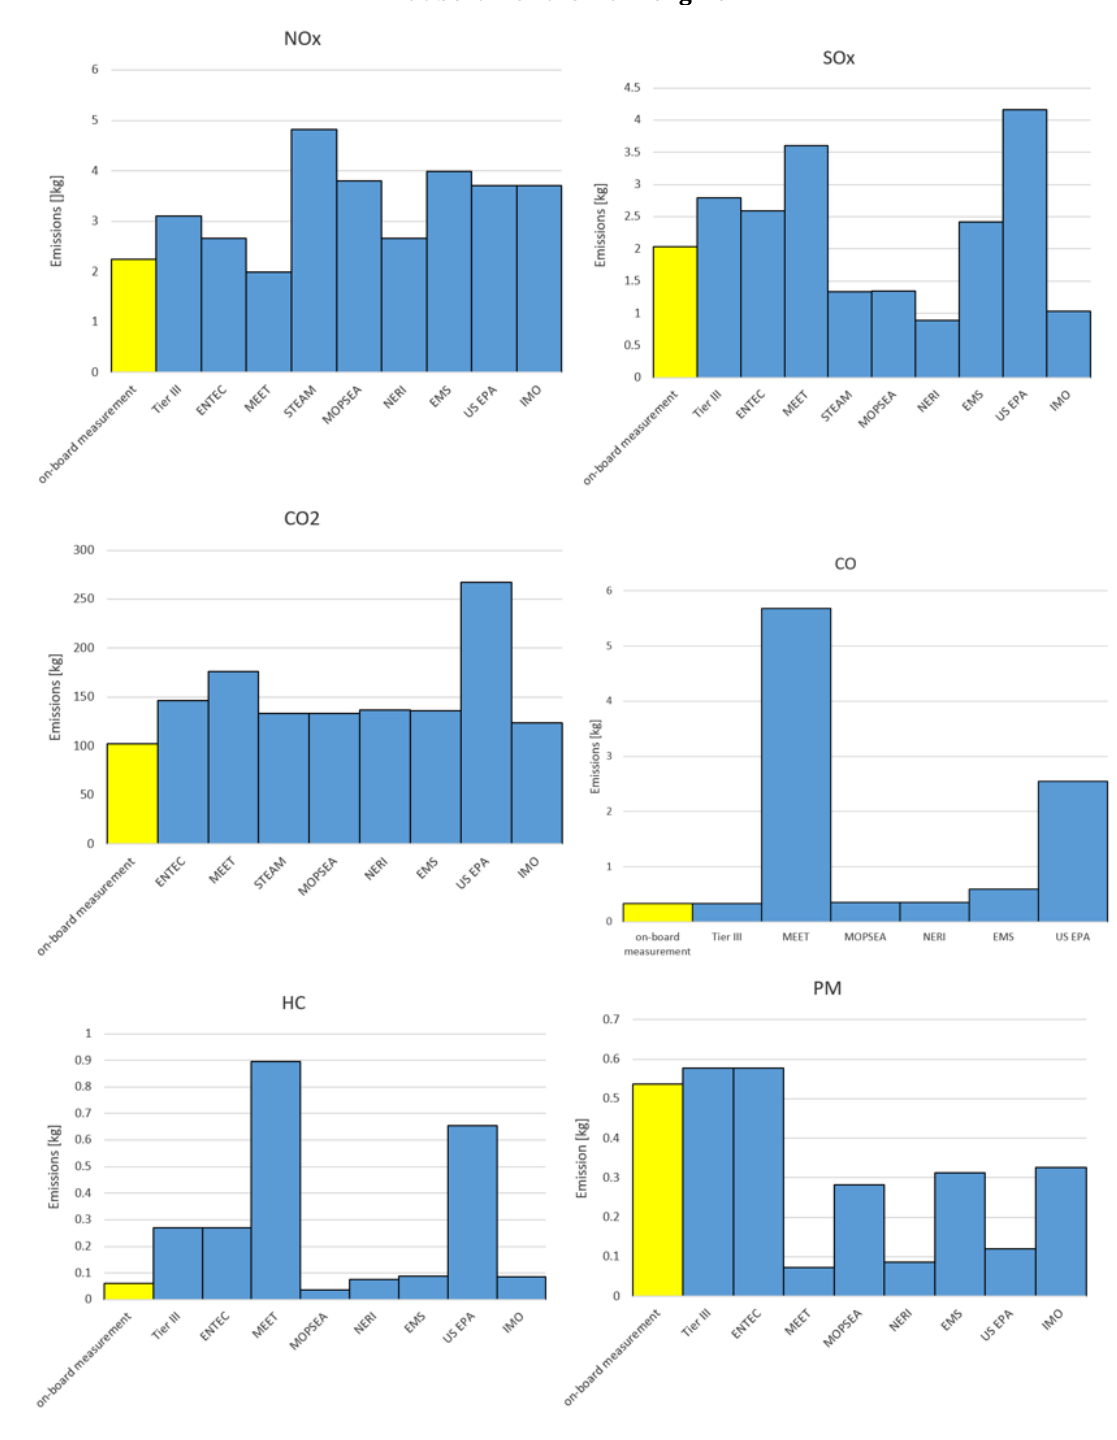
Figure 1: Total emission amounts’ measurement and inventory prediction at berth for the main